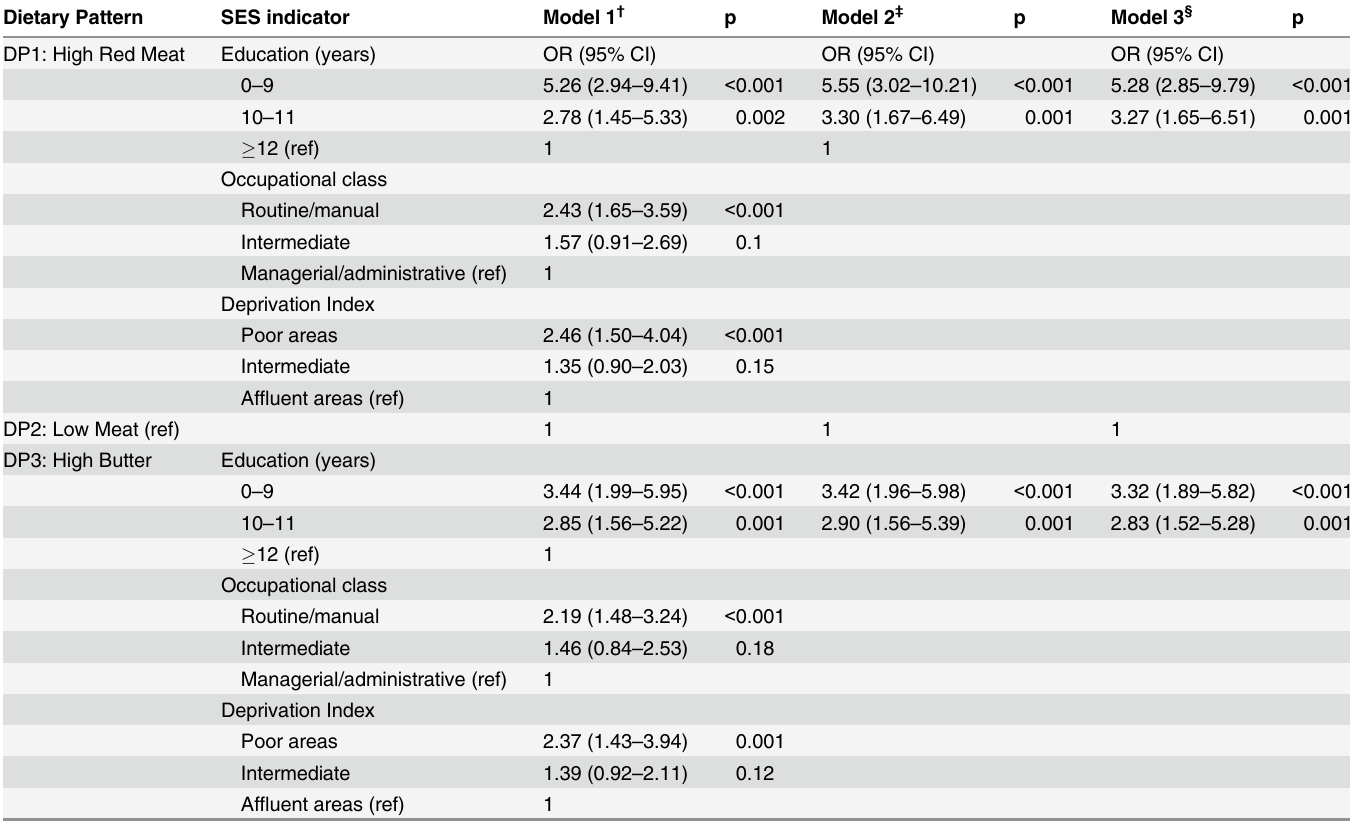
Table 5. Socioeconomic determinants of dietary pattern membership *